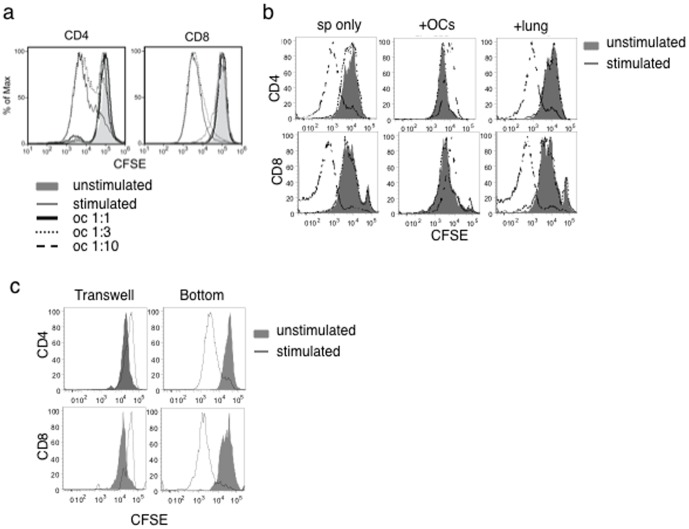
Dose- and cell-cell contact-dependent suppression of T cell proliferation by omentum cells.(a) CFSE labeled splenocytes were cultured with omentum cells at different ratios of omentum cells with or without 1 µg/ml anti-CD3. Cells were labeled with anti-CD4 or anti-CD8 and analyzed by flow cytometry. Omentum cells were added at different ratios to splenocytes (1∶1, 1∶3, or 1∶10) as indicated in the figure. (b) CFSE labeled splenocytes were cultured with omentum cells or lung cells in a 1∶1 ratio and surface labeled as in (a). (c) CFSE labeled splenocytes were cultured in the transwell with or without anti-CD3 across a semi-permeable membrane containing omentum cells and CFSE labeled splenocytes.